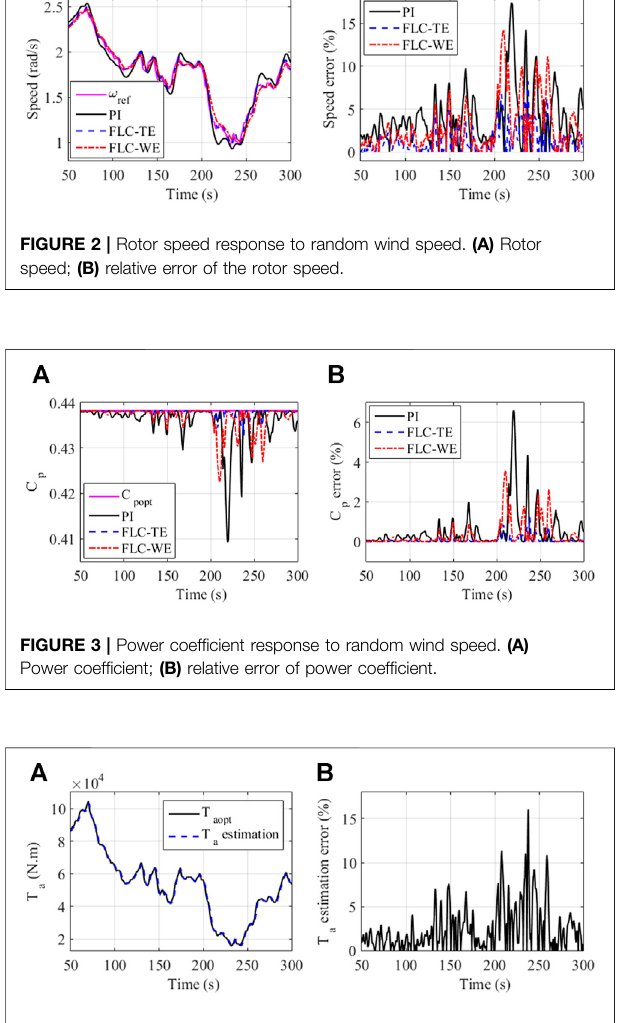
FIGURE 4 | Aerodynamic torque response to random wind speed. (A) Aerodynamic torque estimation; (B) relative error of aerodynamic torque